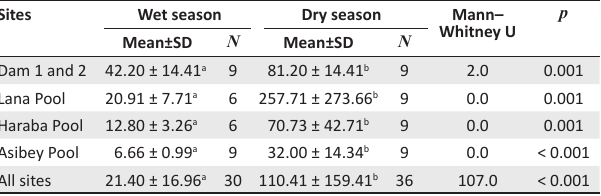
TABLE 4: Mann–Whitney U test of significance difference in seasonal abundance of waterbirds at the four study sites. Sites Wet